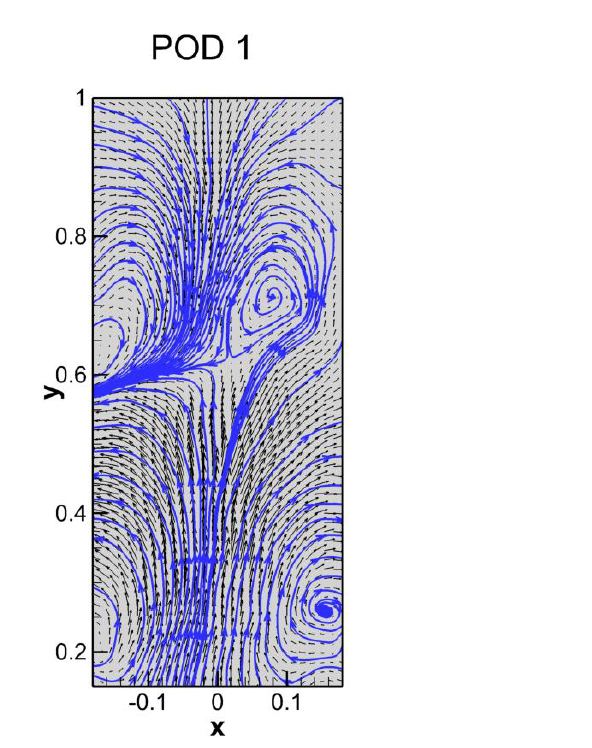
Fig. 10. Velocity POD mode No. 1, 2.8% TKE.